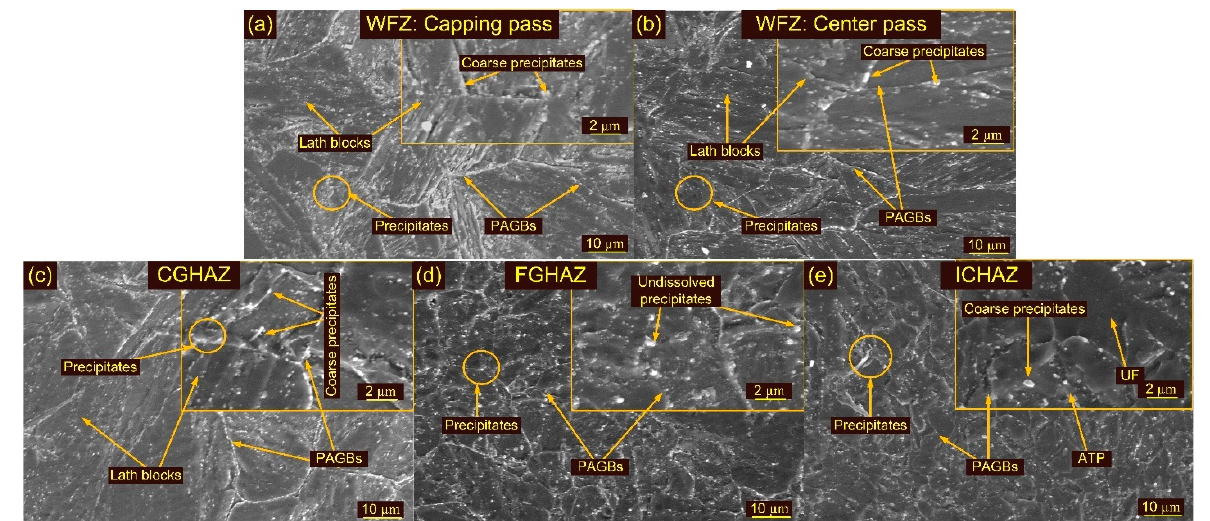
Figure 9. Weldments after T1 treatment: WFZ ( a ) capping pass, ( b ) center pass, ( c ) backing pass; ( d ) CGHAZ, ( e ) FGHAZ, ( f ) ICHAZ.